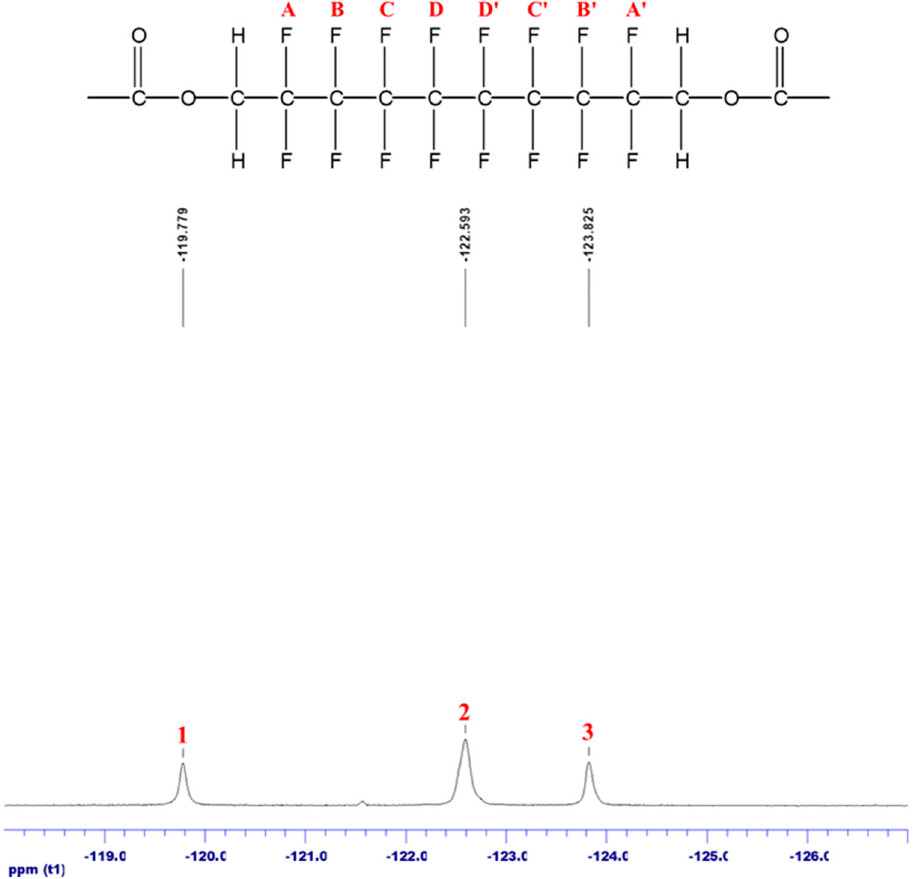
Figure 4. 19 F NMR spectrum and molecular structure of PFD/PU-03.